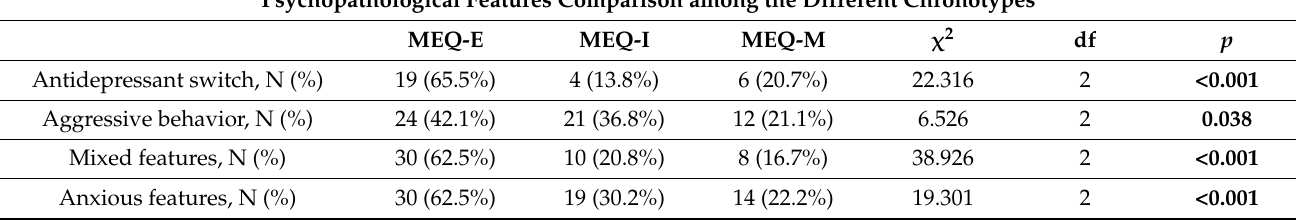
Table 2. Psychopathological features across different chronotypes: χ 2